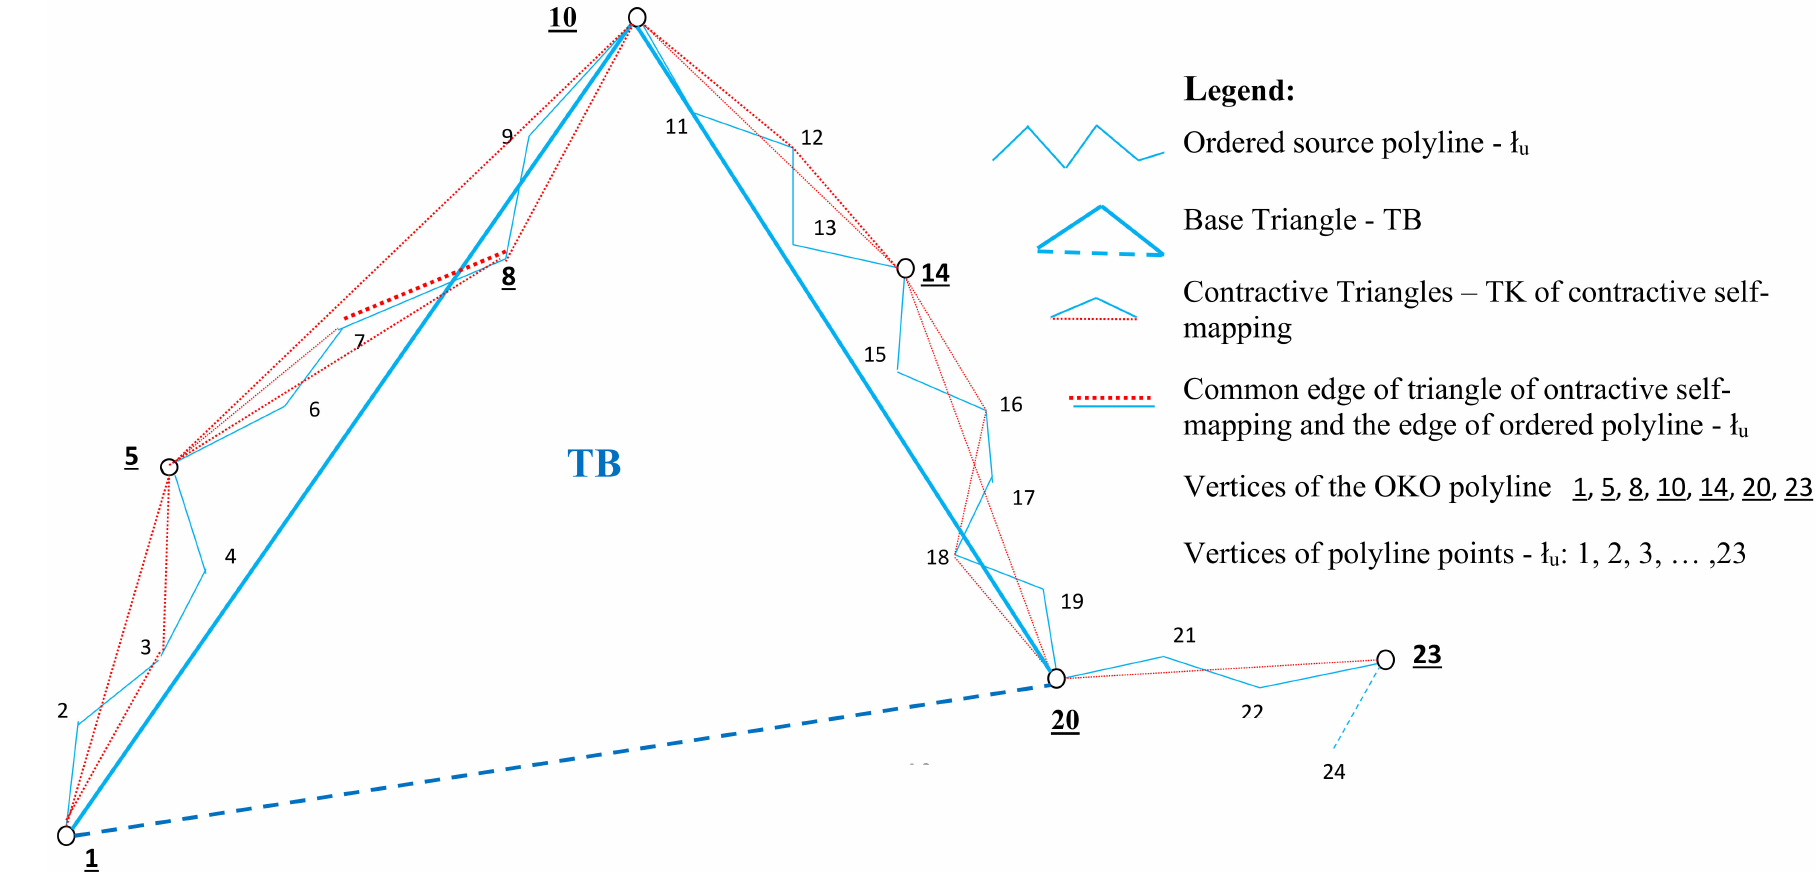
Figure A3. Ordered polyline— l u with contractive mapping of the triangles TK created in binary tree system. Scale